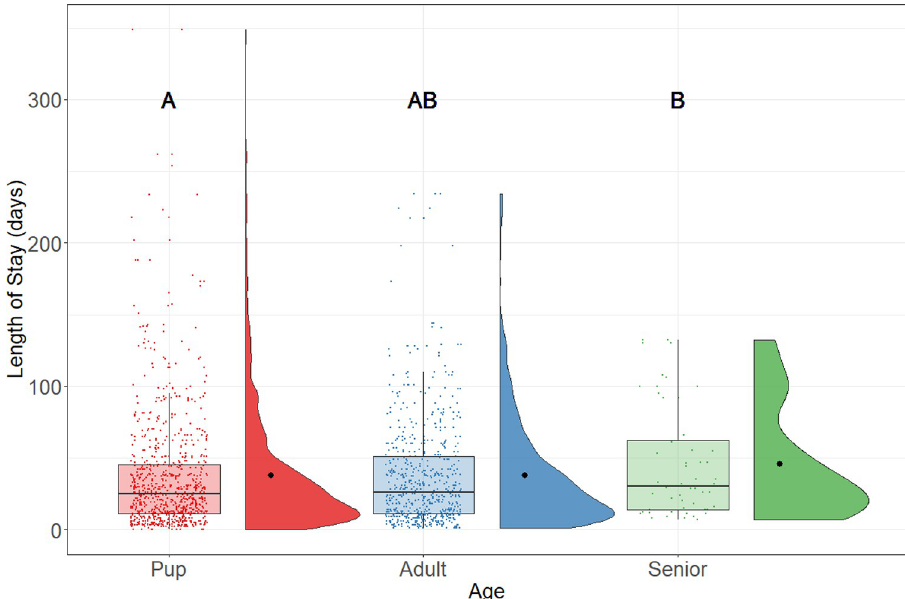
Fig 5. LOS of adopted rats by age. Boxplots represent the median, the 25 and 75 percentiles, with whiskers representing the 95 percentiles. Individual data is shown by dots on the boxplot. Additionally, the rain cloud plots show the distribution and the means in each category.